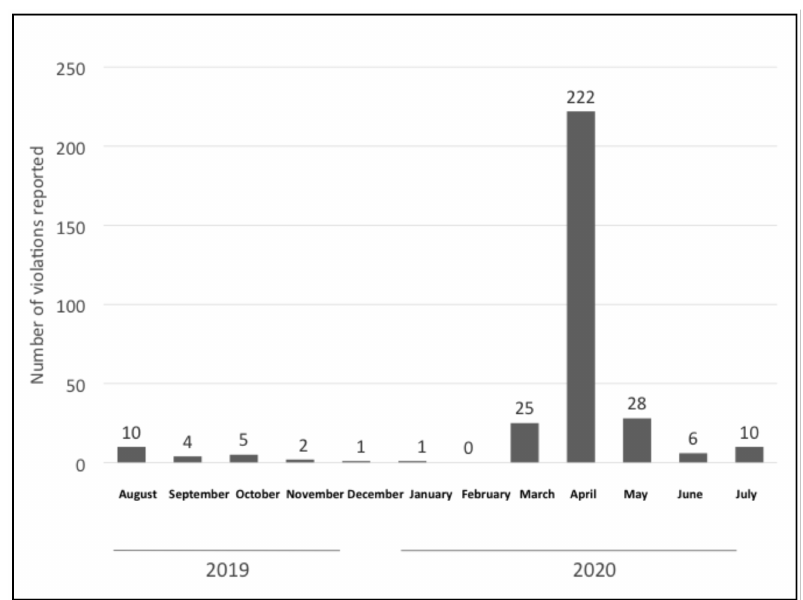
Figure 12. Number of reported violations in the Philippines (January 2019 to July 2020).